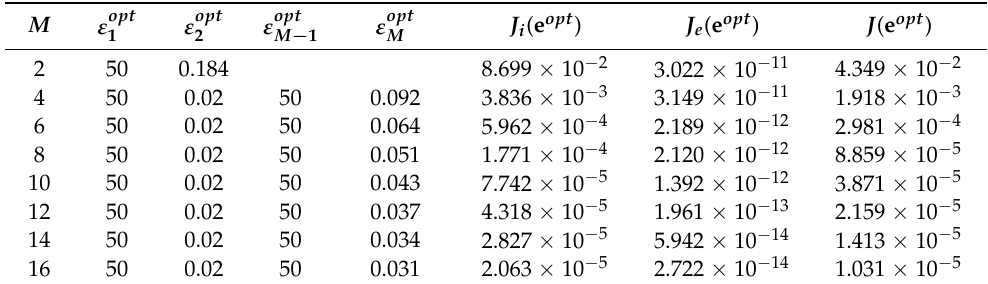
Table 2. Results of solving cloaking problem for ε min = 0.02, ε max = 50; R a = 0.035, R b = 0.050, R = 0.1, Contrast =